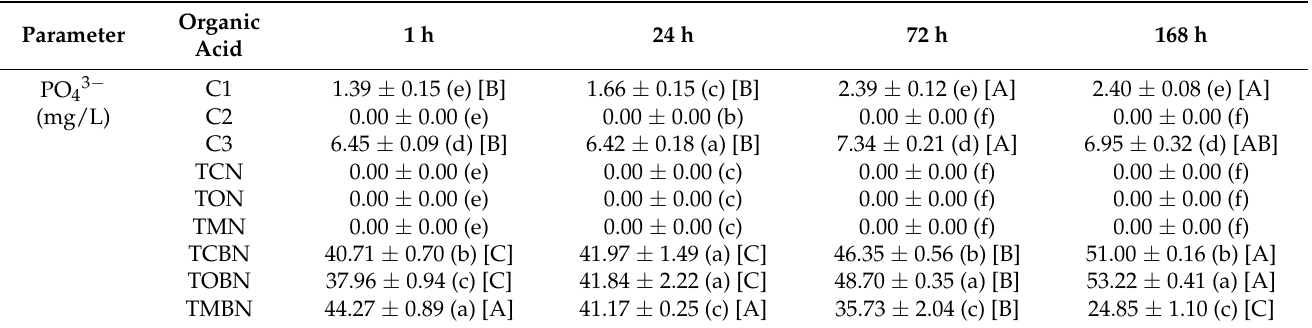
Table 3. Phosphate in the solutions collected at different times during the experiment for the controls and